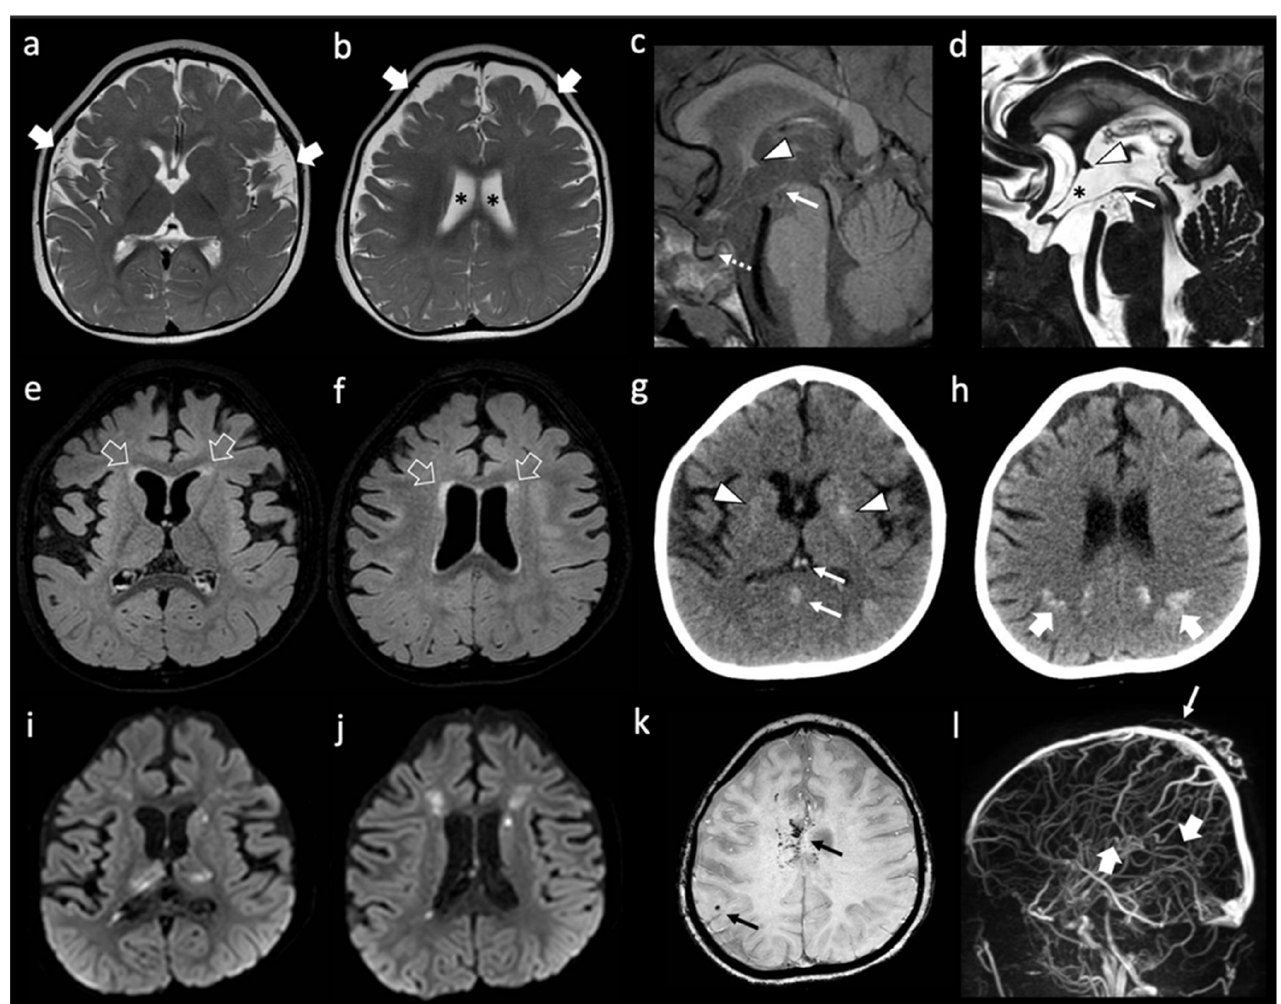
Figure 1. Neuroimaging features of patient A. ( a , b ) Brain MRI with axial T2 ‐ weighted images performed at 1 year of life showing enlargement of the frontal and temporal subarachnoid spaces (thick white arrows) and of the lateral ventricles (black asterisks). Note, the simplified gyration of the cortex, especially in the fronto ‐ temporal lobes. ( c – f ) brain MRI performed at 3 years of age with sagittal T1 ‐ weighted ( c ) sagittal DRIVE ( d ) and axial FLAIR ( e , f ) images reveal dysmorphic anterior commissure (white arrowheads), thin anterior recesses of the third ventricle (black asterisk), absent/dysmorphic mamillary bodies (white arrows), and absent posterior pituitary bright spot (dotted white arrow). There is mild FLAIR hyperintensity of the frontal periventricular white matter (empty white arrows). ( g , h ) non ‐ enhanced head CT images performed a few hours after the onset of right hemiparesis, four days after the previous brain MRI, reveal spontaneous hyper ‐ densities of the internal cerebral veins and straight sinus (thin white arrows). In addition, there are subtle, widespread calcifications of the basal ganglia (white arrowheads) and well ‐ demarcated, band ‐ like calcifications of the subcortical parietal white matter (thick white arrows). ( i – l ) A brain MRI performed the same day of the CT, including diffusion ‐ weighted images ( i , j ) susceptibility weighted imaging ( k ) and phase contrast MR venography ( l ) confirm the absence of blood flow in the straight sinus and internal cerebral veins (thick white arrows) with associated multiple venous ischemic lesions in the thalami and periventricular white matter. In addition, small bleedings are observed in the fronto ‐ mesial and right frontal subcortical white matter (thin black arrows). Note, the parietal median sinus pericranii (thin white arrow).